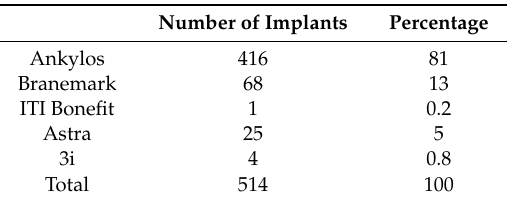
Table 2. Implant systems.